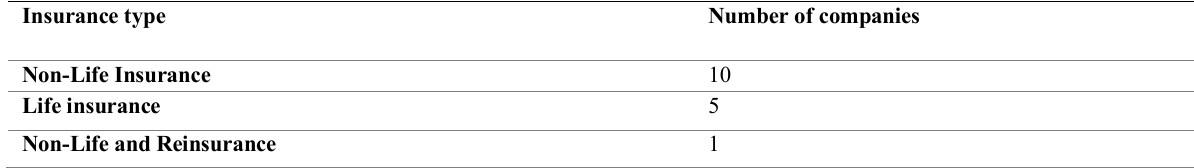
Table 1: Active Operating Insurance Companies in North Macedonia